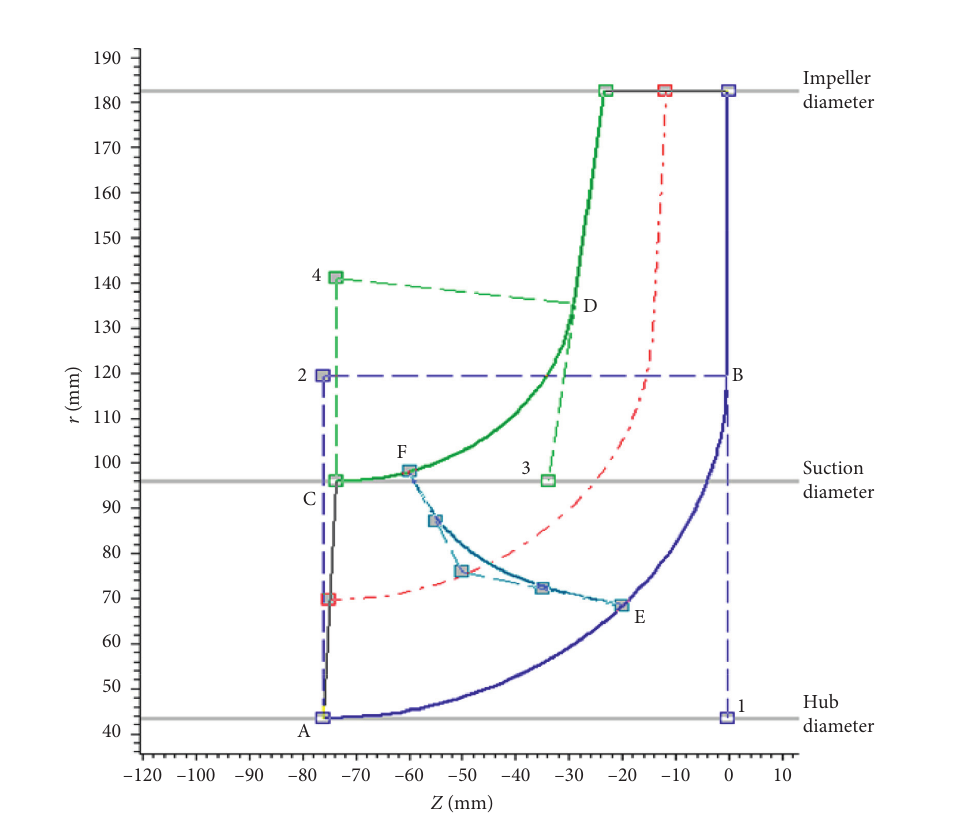
Figure 9: Impeller parameterization and meridional section.